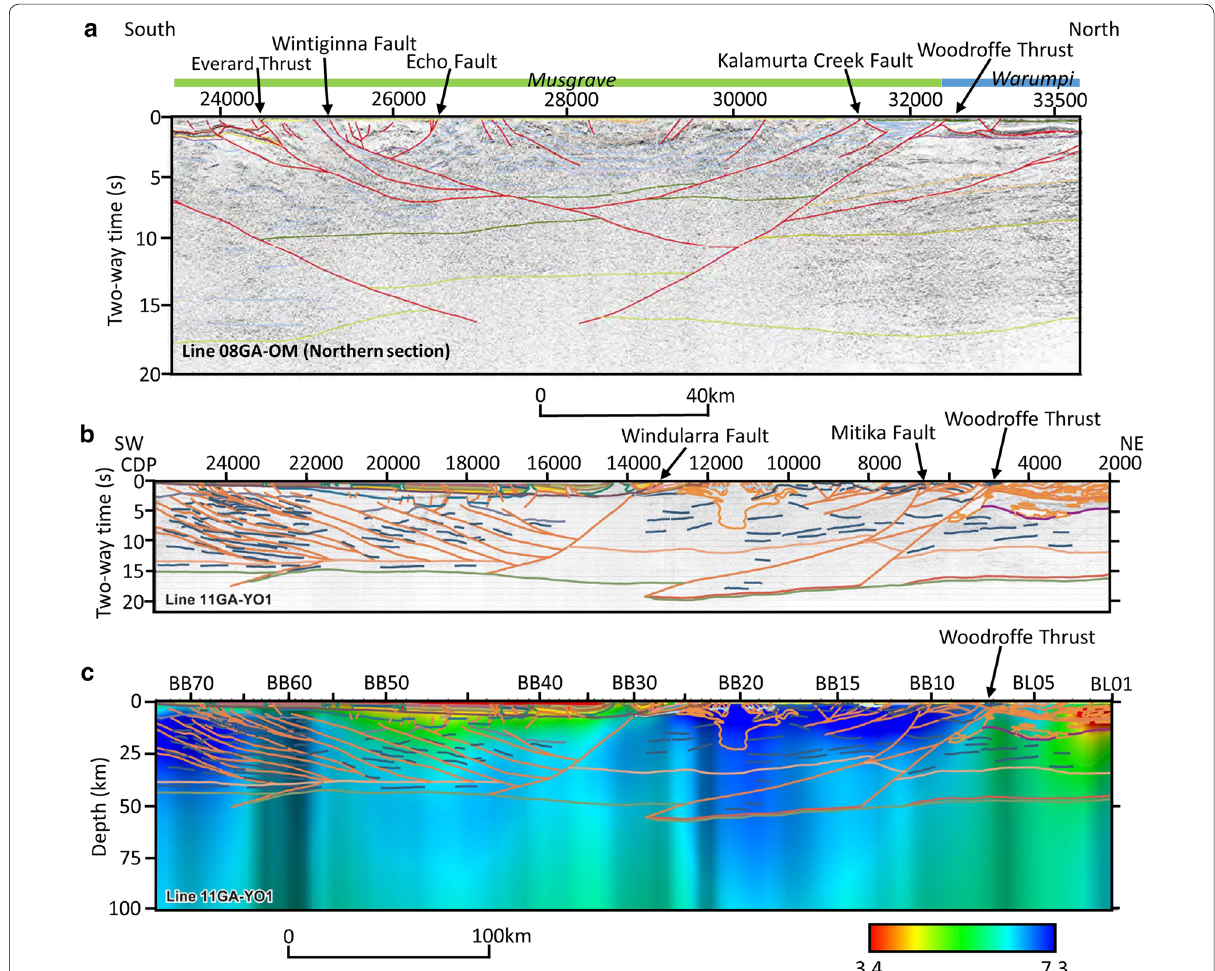
Fig. 10 Deep seismic reflection sections imaging the Musgrave Province. a Interpreted migrated seismic reflection section for the northern portion of the GOMA Seismic Survey (08GA-OM1). Provinces and key faults are named. The display is ∼ 60km depth, with V/H ∼ 1 , assuming an average crustal velocity of 6000m · s − 1 . The location of this seismic traverse is shown in Figs. 1 and 2 (Korsch and Kositcin 2010). b Interpreted migrated seismic reflection section for the north-eastern portion of the YOM Seismic Survey (11GA-YO1). Key faults are named. The display is ∼ 60km depth, with V/H ∼ 1 , assuming an average crustal velocity of 6000m · s − 1 . The location of this seismic traverse is shown in Figs. 1 and 2 (Korsch et al. 2013). c Seismic interpretation from 10B above plotted on 2D MT model acquired along the north-eastern portion of the YOM Seismic Survey (11GA-YO1) (Korsch et al. 2013). All three images are reprinted with permission from Geoscience Australia under copyright Commonwealth of Australia (Geoscience Australia) 2019. This Fig. is released under the Creative Commons Attribution 4.0 International Licence. http://creat iveco mmons